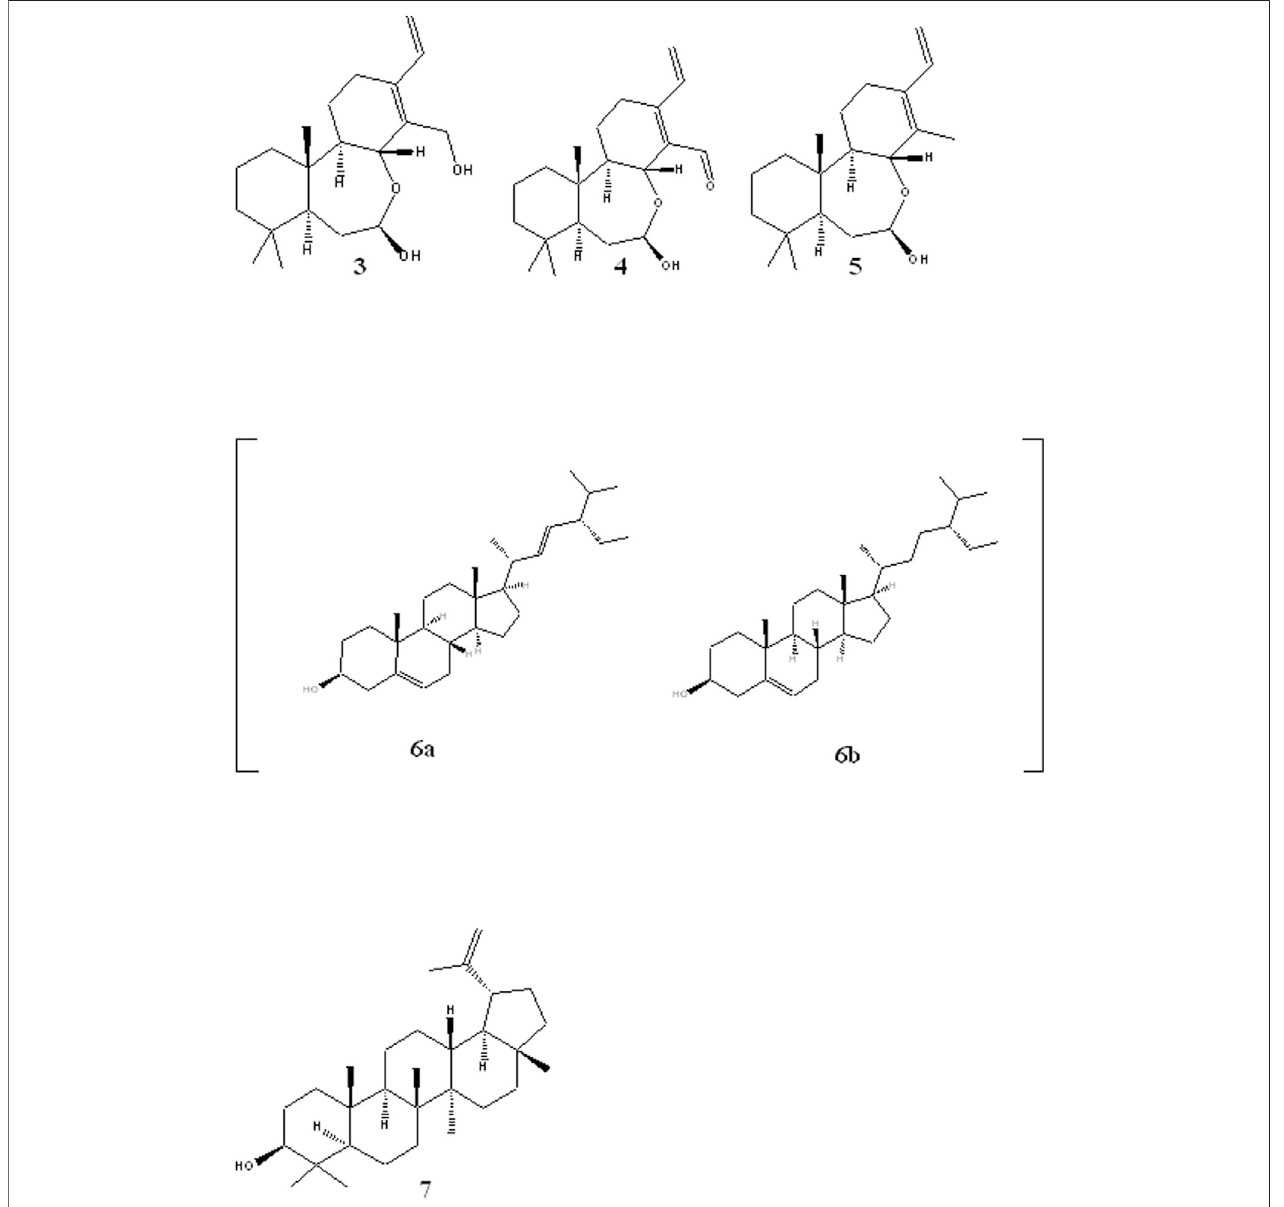
FIGURE 2 | Structures of other isolated compounds: oxacassadienes ( 3 , 4 and 5 ); stigmasterol 6a and β -sitosterol 6b and lupeol 7 .